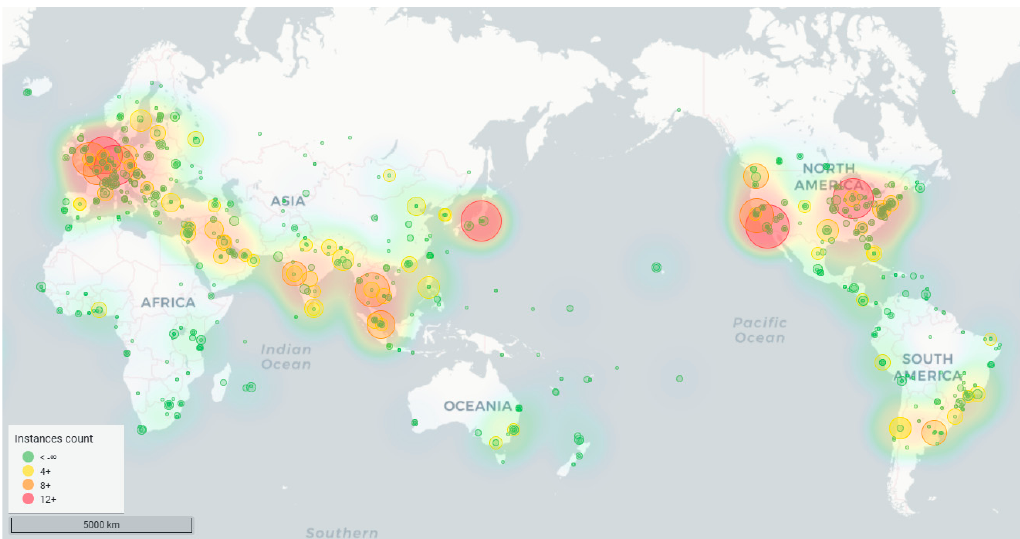
Figure 6. The global distribution map of DNS root mirror instances.